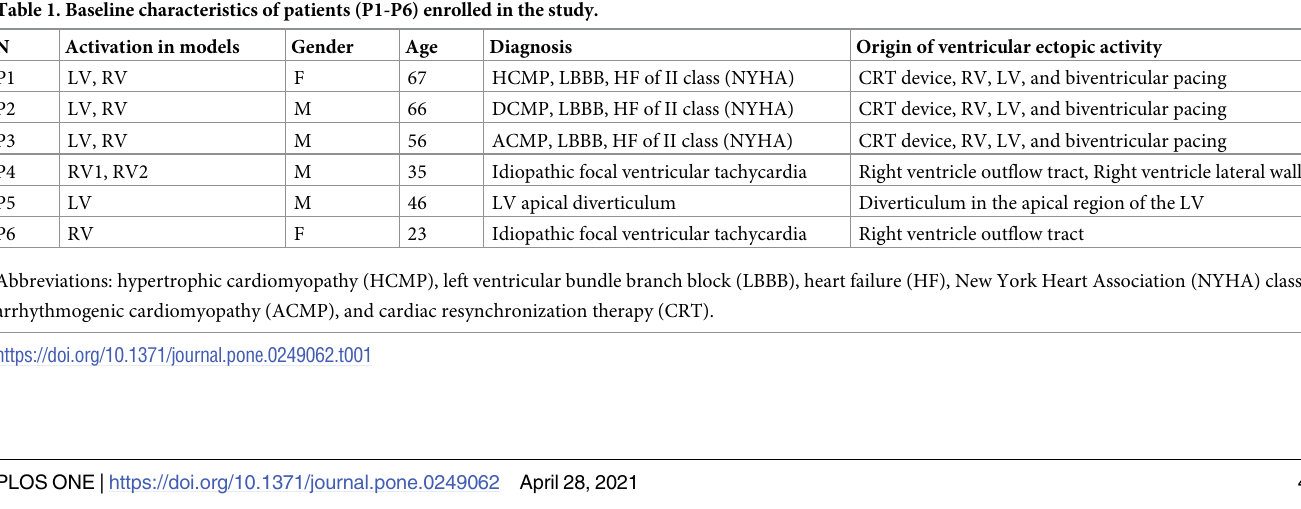
Table 1. Baseline characteristics of patients (P1-P6) enrolled in the study. N Activation in models